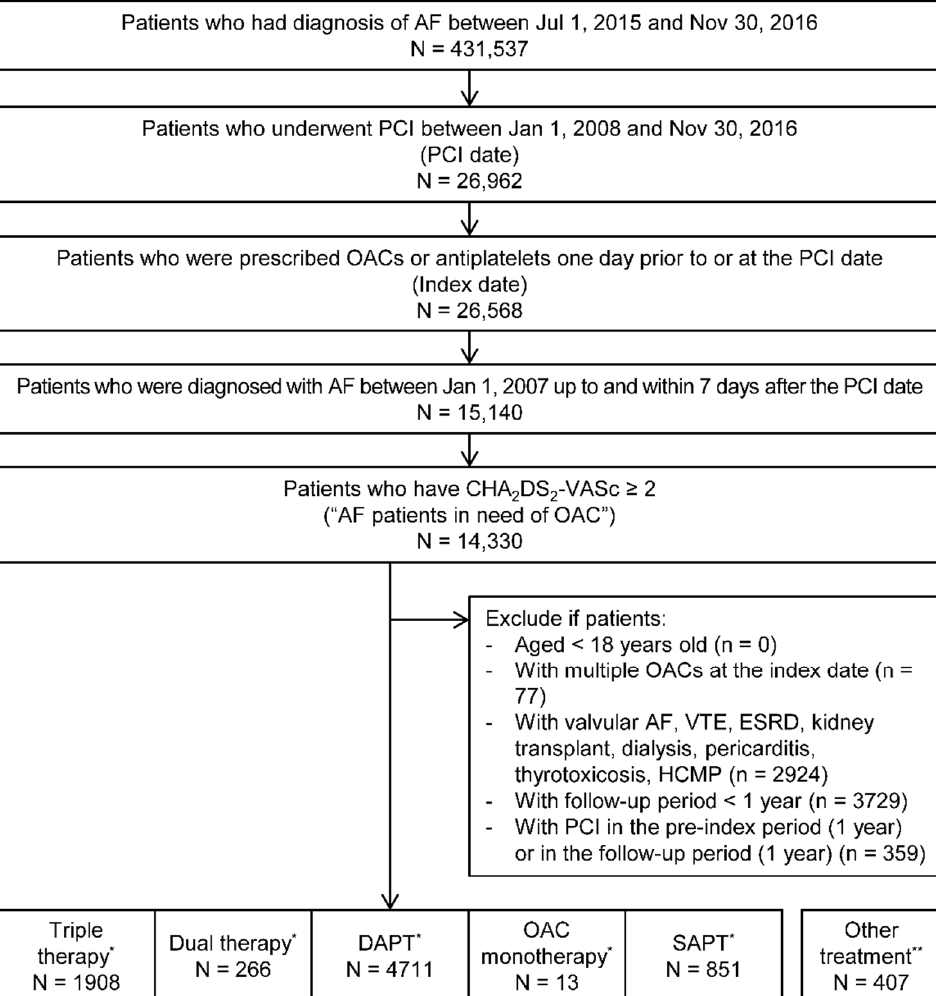
Figure 1. Patient selection flow of patients with atrial fibrillation who underwent percutaneous coronary intervention in need of oral anticoagulants. CHA 2 DS 2 -VASc—congestive heart failure, hypertension, age ≥ 75 years, diabetes mellitus, stroke, vascular disease, age 65–74 years, and sex. AF, atrial fibrillation; DAPT, dual antiplatelet therapy; ESRD, end-stage renal disease; HCMP, hypertrophic cardiomyopathy; OAC, oral anticoagulants; PCI, percutaneous coronary intervention; SAPT, single antiplatelet therapy; VTE, venous thromboembolism. * Triple therapy means OAC plus DAPT. Dual therapy means OAC plus SAPT. DAPT means aspirin plus clopidogrel/prasugrel/ticagrelor. OAC monotherapy means apixaban, dabigatran, rivaroxaban, or warfarin. SAPT means aspirin, clopidogrel, prasugrel, or ticagrelor. ** Other treatments included the following concomitant uses: clopidogrel plus prasugrel; clopidogrel plus ticagrelor; aspirin plus clopidogrel plus prasugrel; aspirin plus clopidogrel plus ticagrelor; aspirin plus prasugrel plus ticagrelor; and aspirin plus clopidogrel plus prasugrel plus ticagrelor.